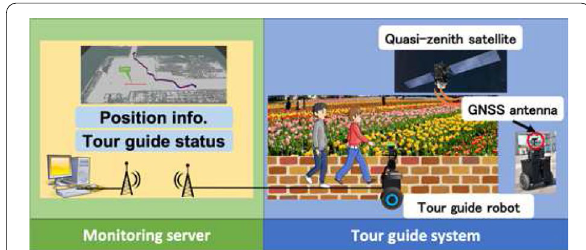
Fig. 1 Conceptual diagrams of the tour guide system. The robot conducts a tour using QZSS, and some information obtained from the robot is monitored from the server